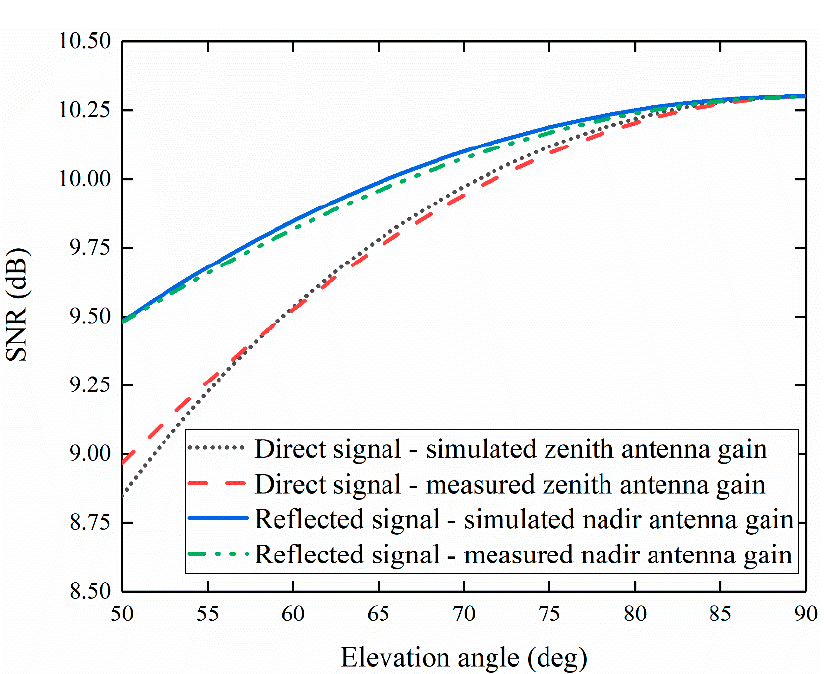
Figure 9. SNR by adopting the NDCPPA verification prototype: the comparison of simulated antenna gain and measured antenna gain brought into the simulation environment.